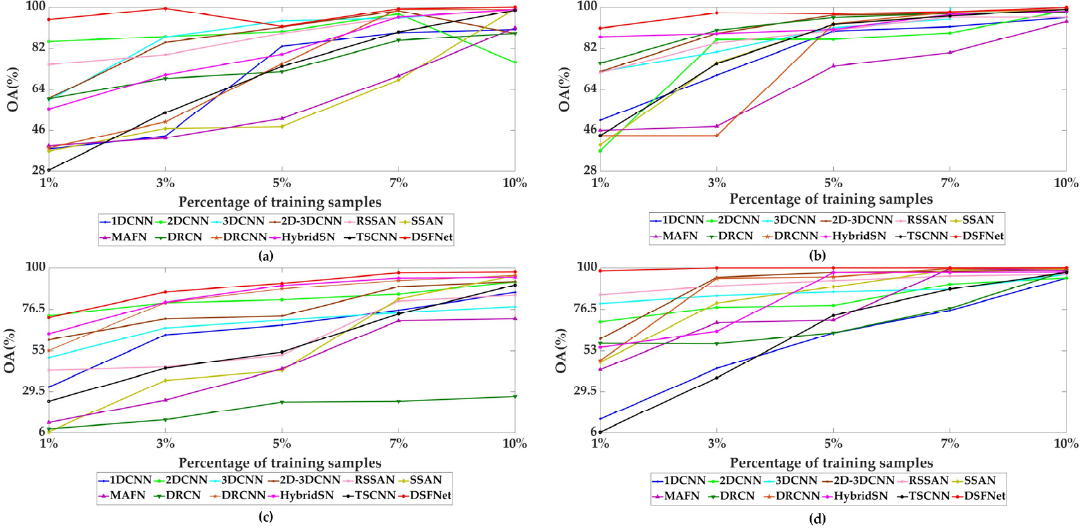
Figure 19. OA of different methods for different percentage of training samples on four HSI data sets: ( a ) SAC dataset; ( b ) UP dataset; ( c ) IP dataset; ( d ) SA dataset.